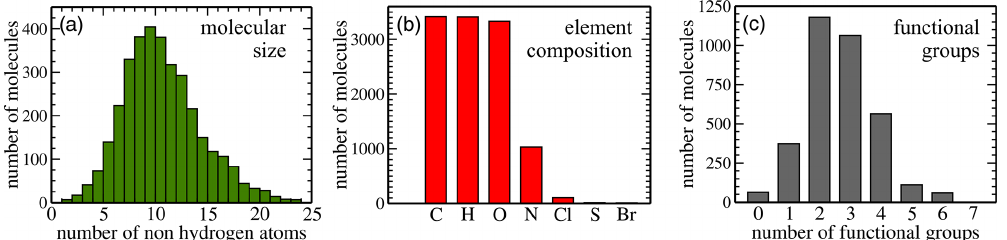
Figure 2. Dataset statistics: panel (a) shows the size distribution (in terms of the number of non-hydrogen atoms) of all 3414 molecules in the dataset. Panel (b) illustrates how many molecules contain each of the chemical species, and panel (c) depicts the functional group